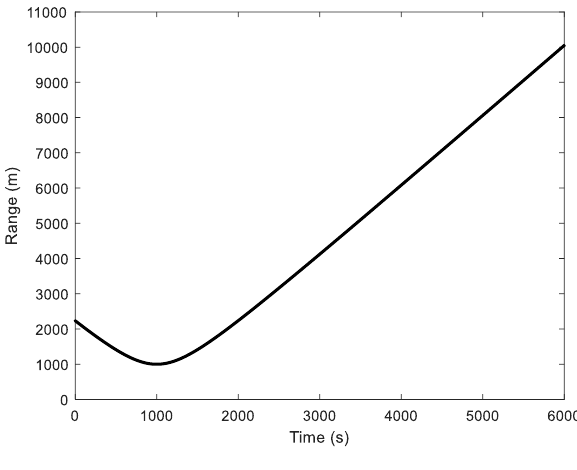
Figure 5. Estimated source range.